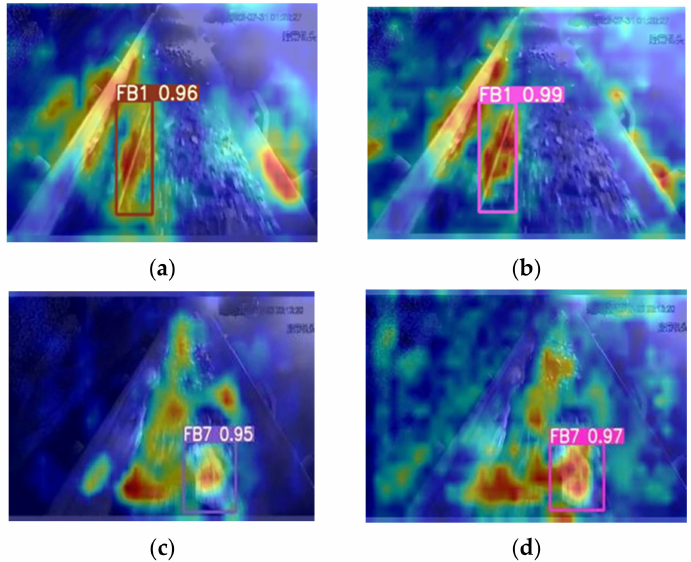
Figure 14. Activation heatmap of foreign objects of YOLOv5 before and after improvement. ( a ) Heatmap of the anchor with YOLOv5. ( b ) Heatmap of the anchor with the improved YOLOv5 algorithm. ( c ) Heatmap of the gangue with YOLOv5. ( d ) Heatmap of the gangue with the improved YOLOv5 algorithm.